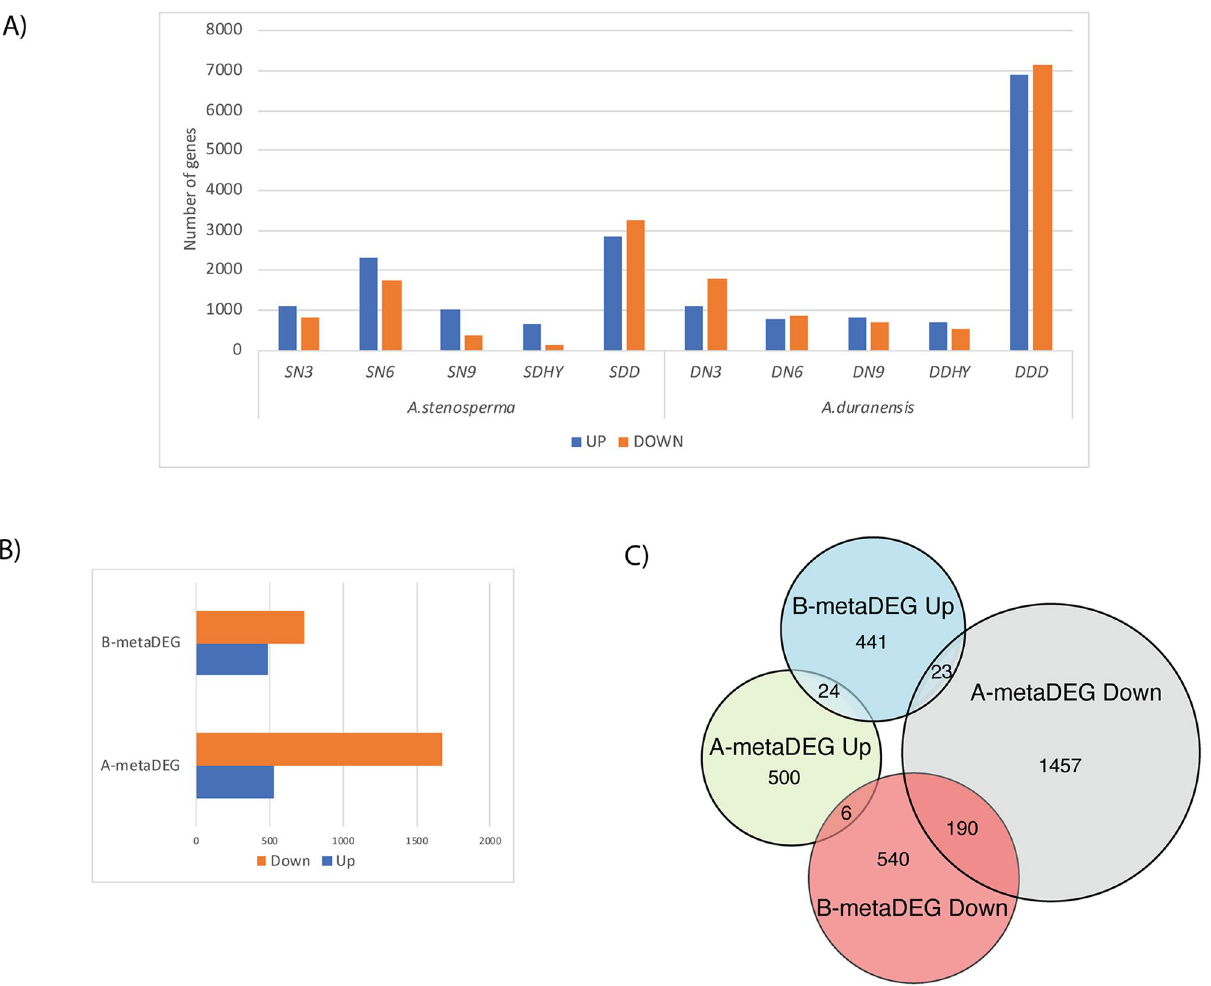
Figure 1. Arachis spp transcriptome libraries used in the meta-analysis: (A) Number of DEGs up- and downregulated in A. stenosperma and A. duranensis plants submitted to biotic and abiotic stress. (B) Number and expression trend of metaDEGs found in biotic and abiotic stress categories. (C) Euler diagram showing metaDEGs distribution according to stress category and their expression trend. A. stenosperma inoculated with nematode at 3DAI, 6DAI and 9DAI (SN3, SN6, SN9), A. stenosperma submitted to dehydration (SDHY) and dry-down (SDD). A. duranensis inoculated with nematode at 3DAI, 6DAI and 9DAI (DN3, DN6, DN9), A. duranensis submitted to dehydration (DDHY) and dry-down